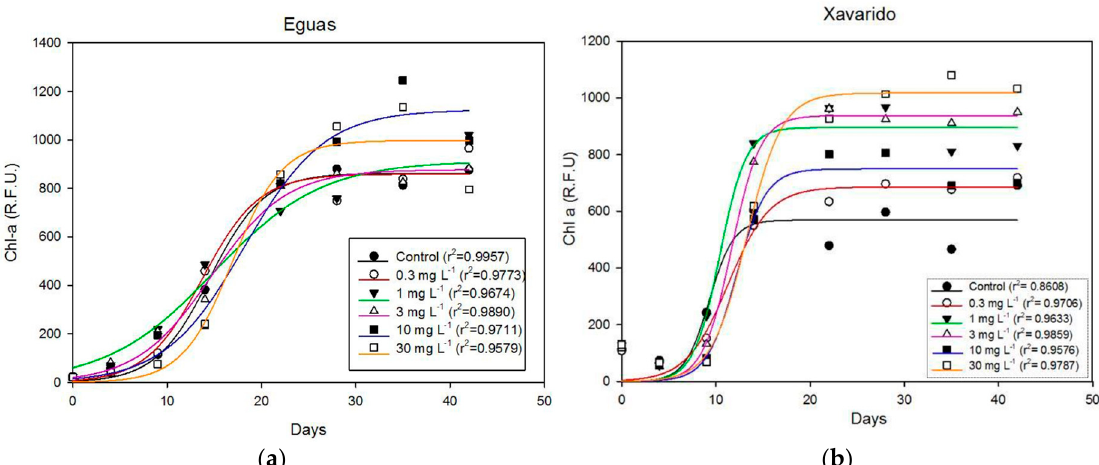
Figure 1. Biofilm growth on sediments exposed to increasing As concentrations, measured by Chl-a fluorescence (F 0 ) expressed in Relative Fluoresce Units (R.F.U.). ( a ) Eguas systems. ( b ) Xavarido systems. Data were obtained at day 4, 9, 14, 22, 28, 35 and 42.